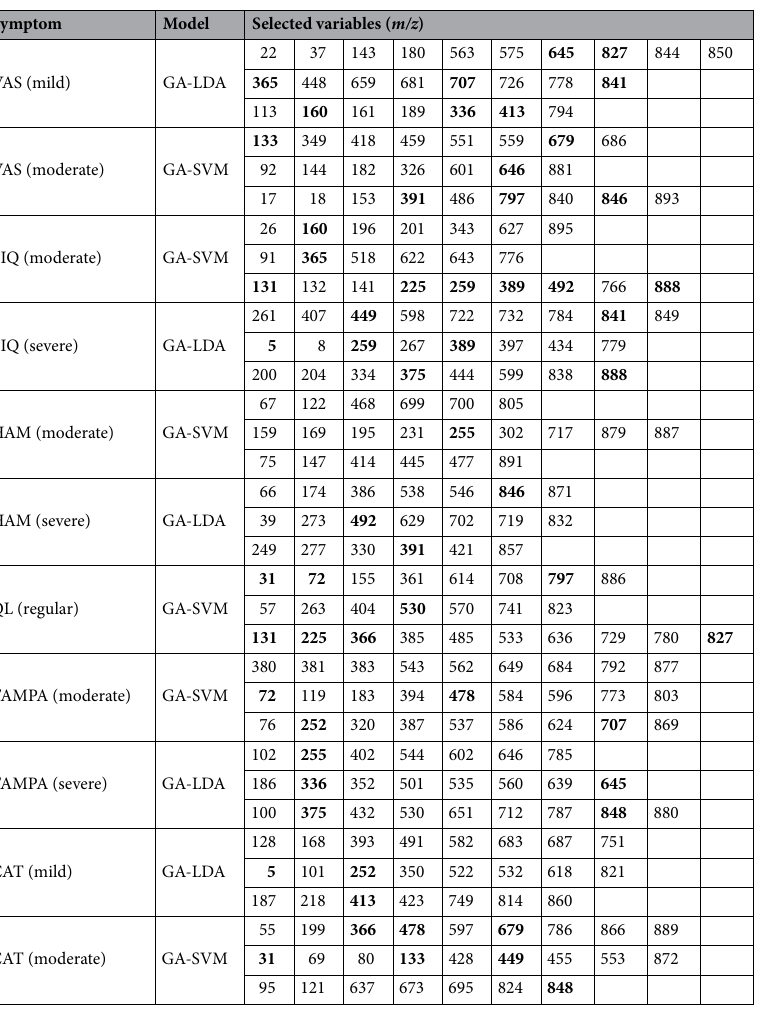
Table 2. Variables selected by the GA models for the levels of symptoms studied. Symptoms: VAS Visual Analog Scale of Pain, FIQ Fibromyalgia Impact Questionnaire, HAM Hamilton Anxiety Rating Scale, QL Quality of Life index, TAMPA The Tampa Kinesiophobia Scale, CAT Pain Catastrophizing Scale. Models: GA-LDA genetic algorithm with linear discriminant analysis, GA-SVM genetic algorithm with support vector machines. The values in bold represent the variables that occurred in more than one model, totaling 31 different